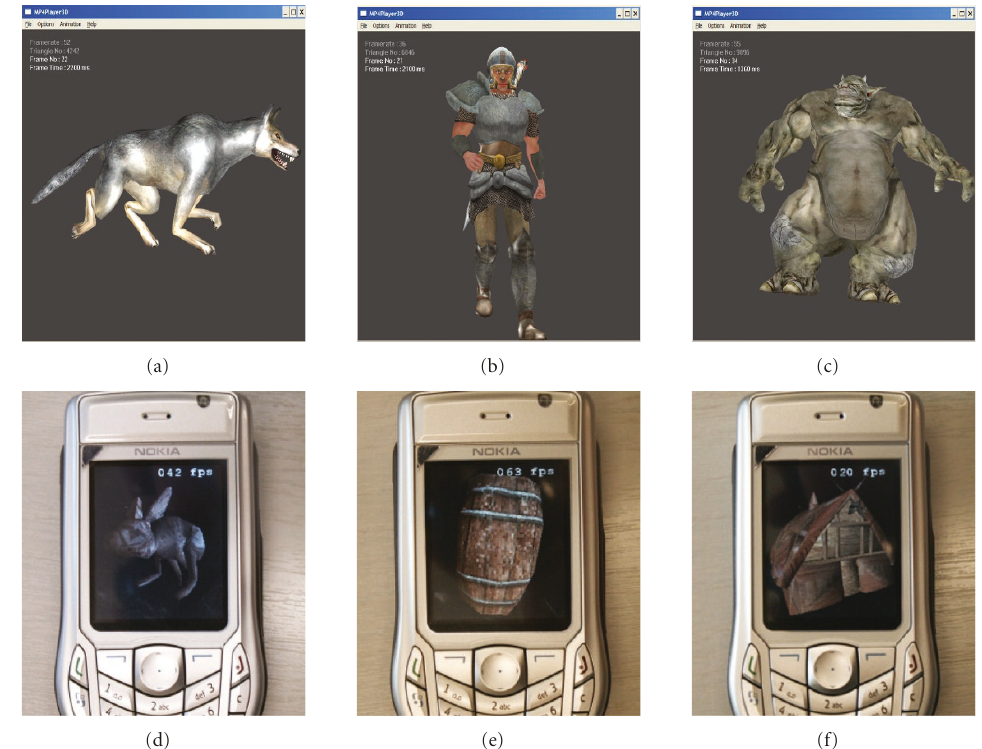
Figure 13: Some OLGA models loaded in the PC (top) and CP (bottom) versions of the 3D graphics MPEG-4